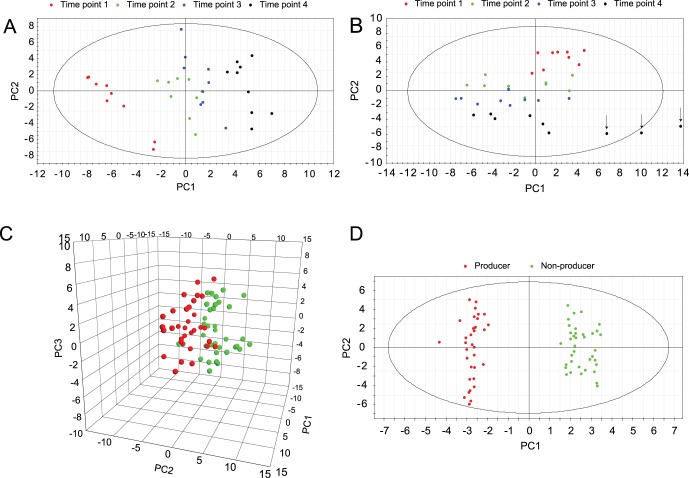
Multivariate analysis of intracellular metabolite concentrations.Principal component analysis (PCA) and orthogonal projection to latent structures - discriminant analysis (OPLS-DA) was used to explore intracellular metabolite concentrations of producer and non-producer cultures. (A) Score scatter plot of the first two principal components of non-producer samples. (B) Score scatter plot of the first two principal components of producer samples. Arrows indicate outliers, believed to be a consequence of incorrect cell counts, which were removed. (C) 3D score scatter plot of the first three principal components of producer (red) and non-producer (green) samples. (D) OPLS-DA score scatter plot of producer (red) and non-producer samples (green).